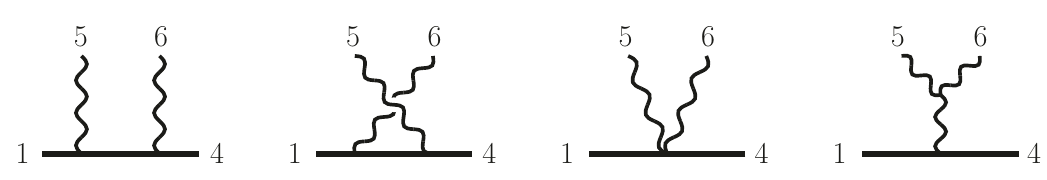
Figure 4 . The Compton-amplitude Feynman diagrams. The straight line corresponds to the spinning particle. The wiggly lines correspond to